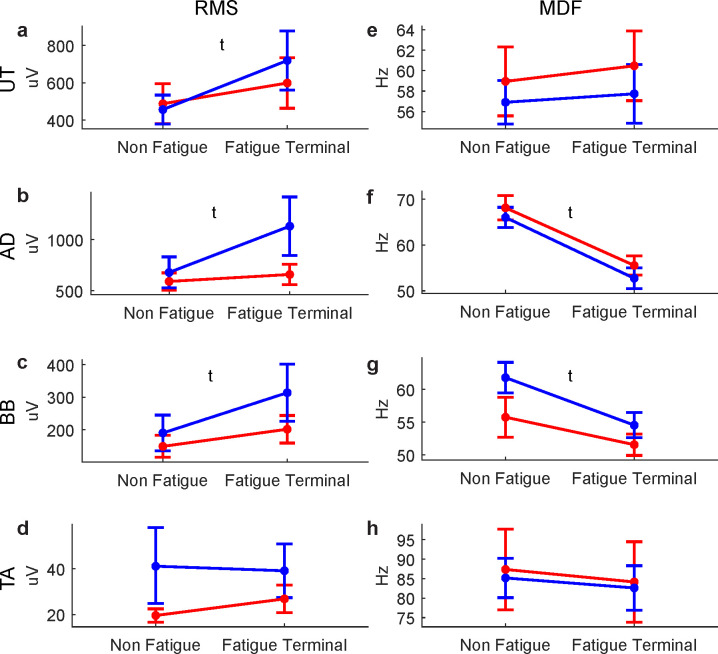
Effects of fatigue and sex on motor variables.The left panels present EMG root mean square (RMS) for the upper trapezius (UT, a), anterior deltoid (AD, b), biceps brachii (BB, c) and tibialis anterior (TA, d) muscles. The right panels present the EMG median frequency (MDF) for the UT, AD, BB and TA. s: main effect of sex, t: main effect of time, s x t: interaction (absent). Women’s and men’s data are represented in red and blue, respectively.